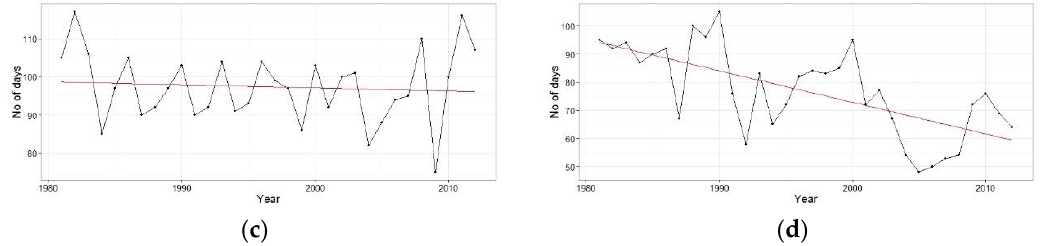
Figure 6. Number of rainfall days from the selected stations inside the KRB; ( a ) In Terai, ( b ) in hills, ( c ) in mountain, and ( d ) mountain valley.